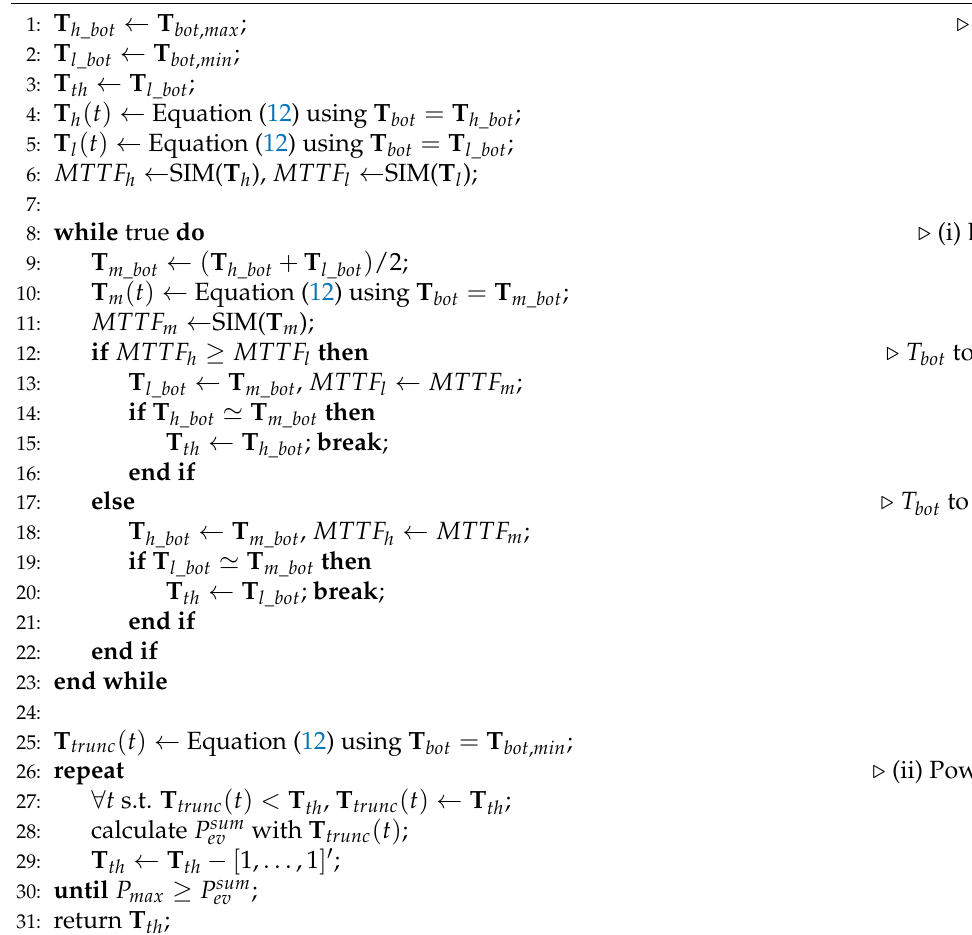
Figure 3. ( a ) Example temperature traces compared in the binary search and ( b ) the truncated envelope temperature and the temperature threshold. Algorithm 2 Derivation of the Temperature